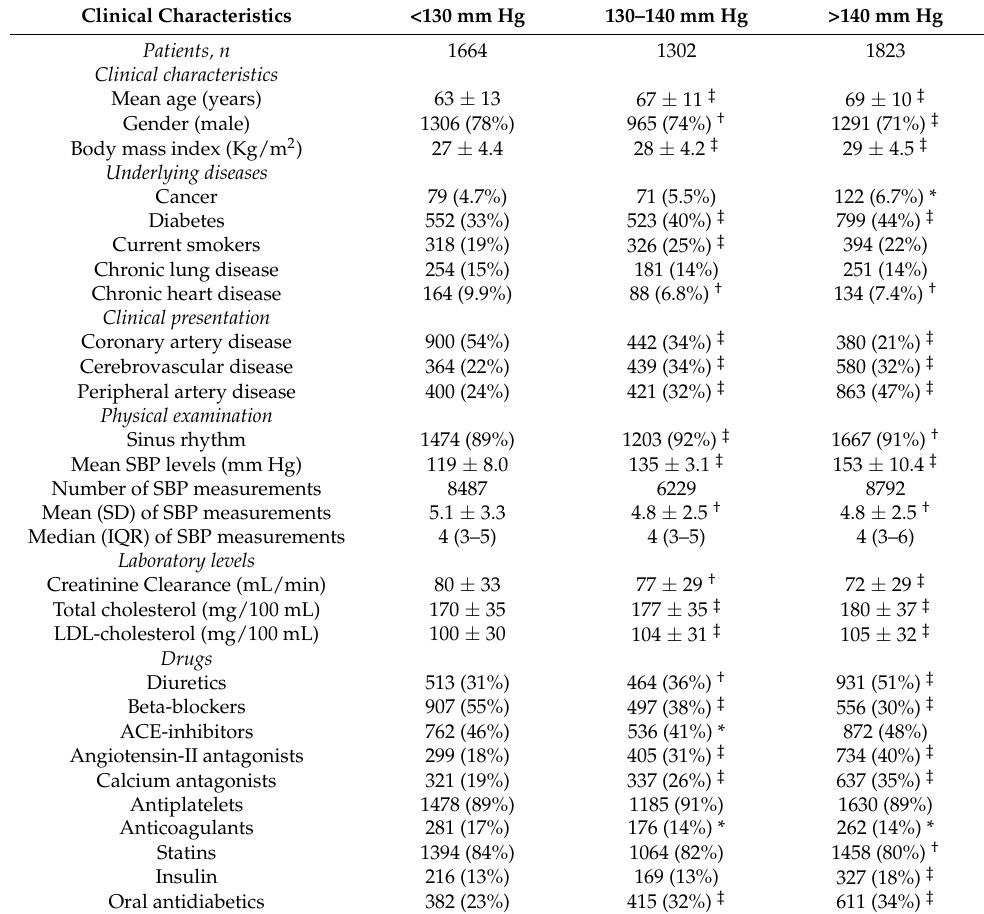
Table 1. Clinical characteristics of the patients according to their mean SBP levels during follow